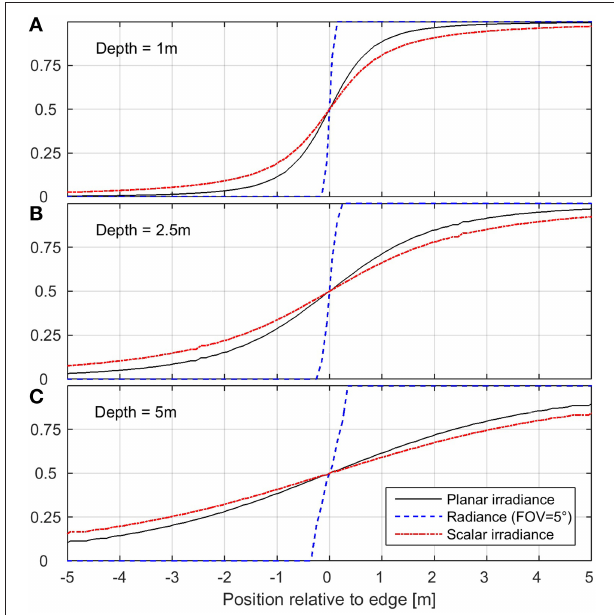
FIGURE 4 | Lateral transect of light measurements across a semi-infinite boundary in 1m (A), 2.5m (B), and 5m (C) depth below the ice water interface.